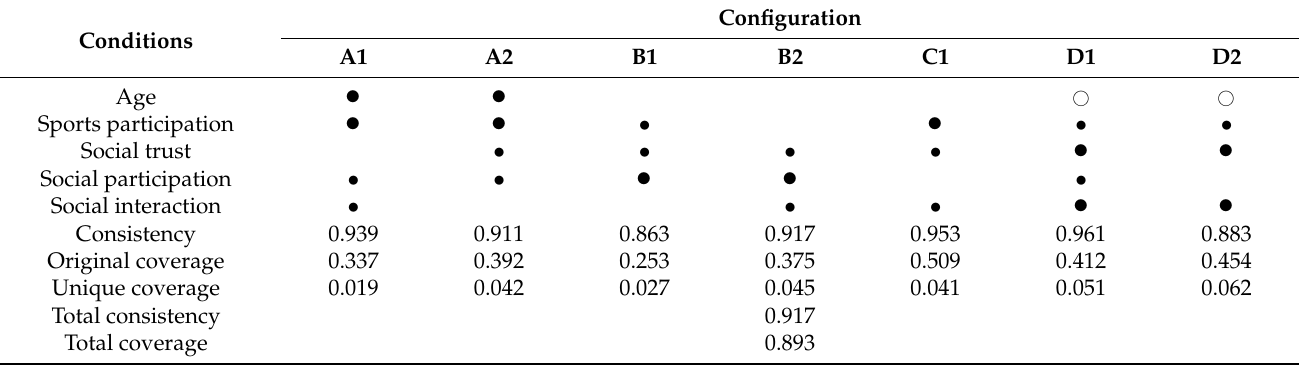
Table 8. Results of the analysis of conditional groups of positive well-being in older